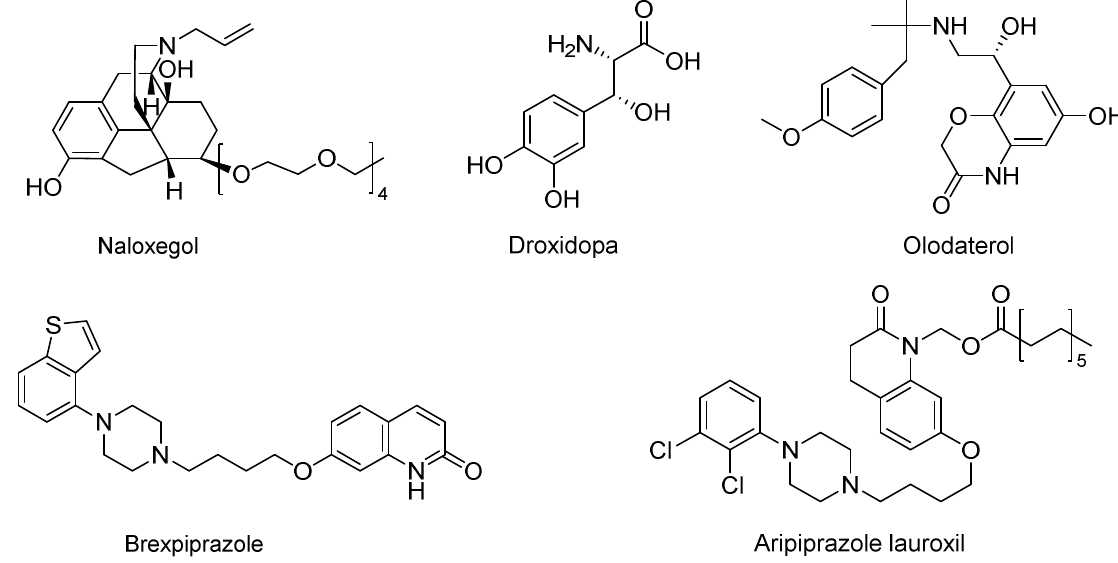
Figure 1. Chemical structures of drugs targeting GPCRs approved by the